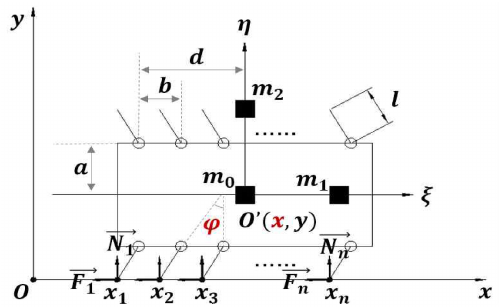
Figure 3. The free body diagram of a hybrid soft